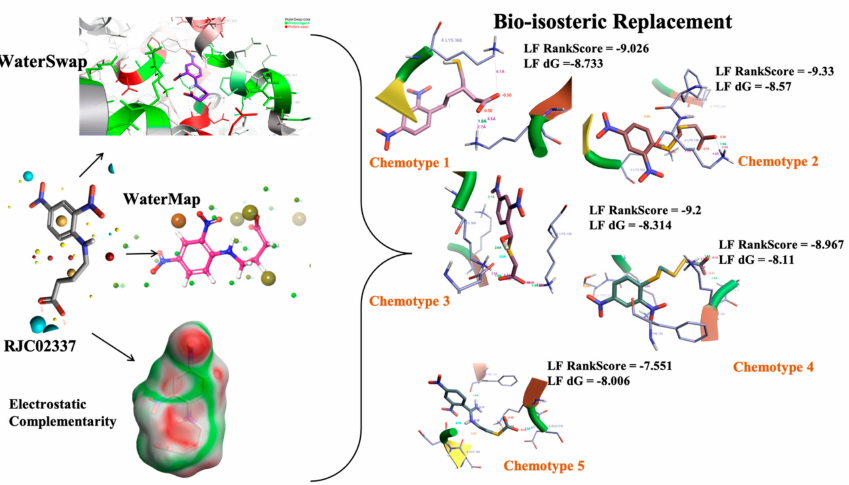
Figure 7. The 2D structure of compound RJC02337, WaterSwap analysis of PfDegP with compound RJC02337: Residues Lys368, Lys350, Lys139, Lys142, Arg141, Lys88, Pro138, Lys136, Lys209